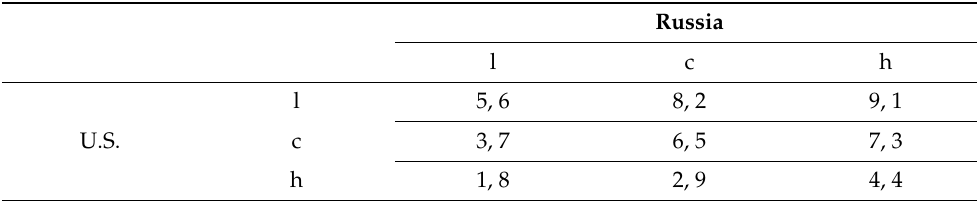
Table 9. Payoff matrix for Russia-U.S. subgame sanctioned